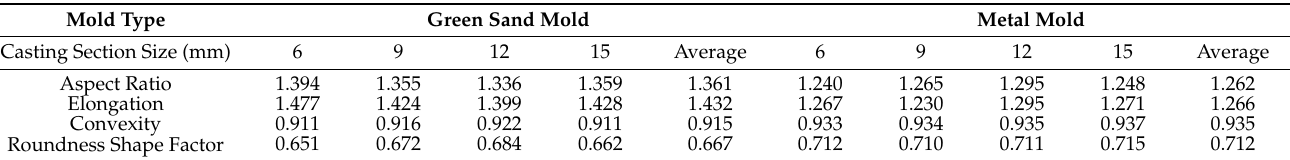
Table 3. Graphite shape